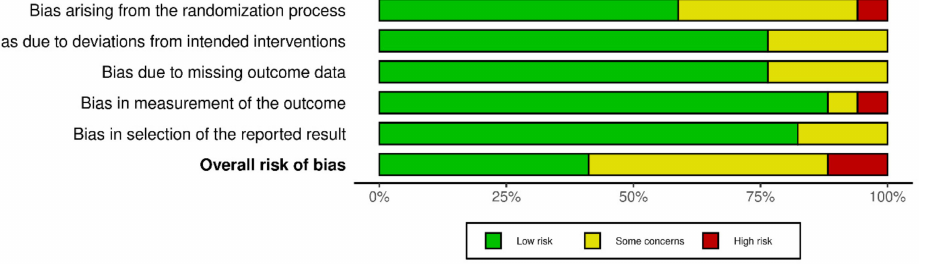
Figure 7. Summary of risk of